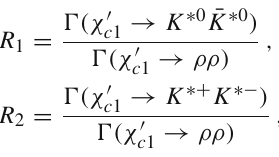
Fig. 5 α -dependence of the decay width of χ (cid:2) 3 . 930 GeV bounds of BR (χ (cid:2) and 3 . 03 × 10 − 4 ,